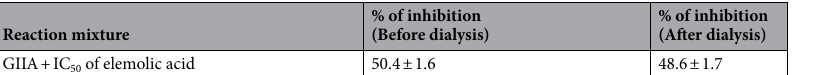
Table 4. Inhibition of GIIA enzyme activity by elemolic acid before and after dialysis. The data are expressed in mean ± standard deviation (n = 3).